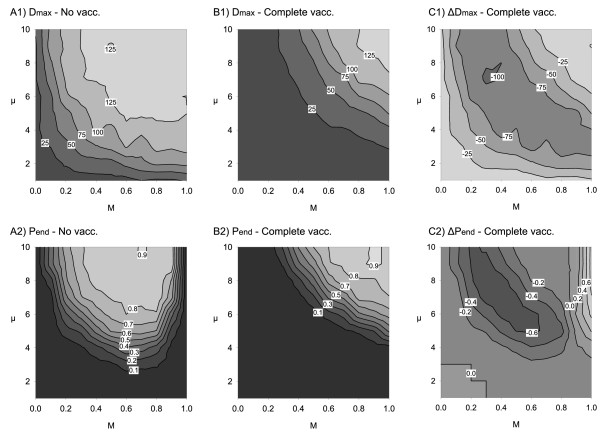
(A) No vaccination, (B) complete vaccination, (C) pointwise difference between B and A. (A1, B1, C1) Median of the maximum achieved distance of the virus from the release point Dmax without vaccination, with vaccination, and the amount of change between both. (A2, B2, C2) probability of virus endemicity Pend without vaccination, with vaccination and the amount of change between both. All are plotted vs. case mortality M and mean infectious period of lethally infected hosts μ.